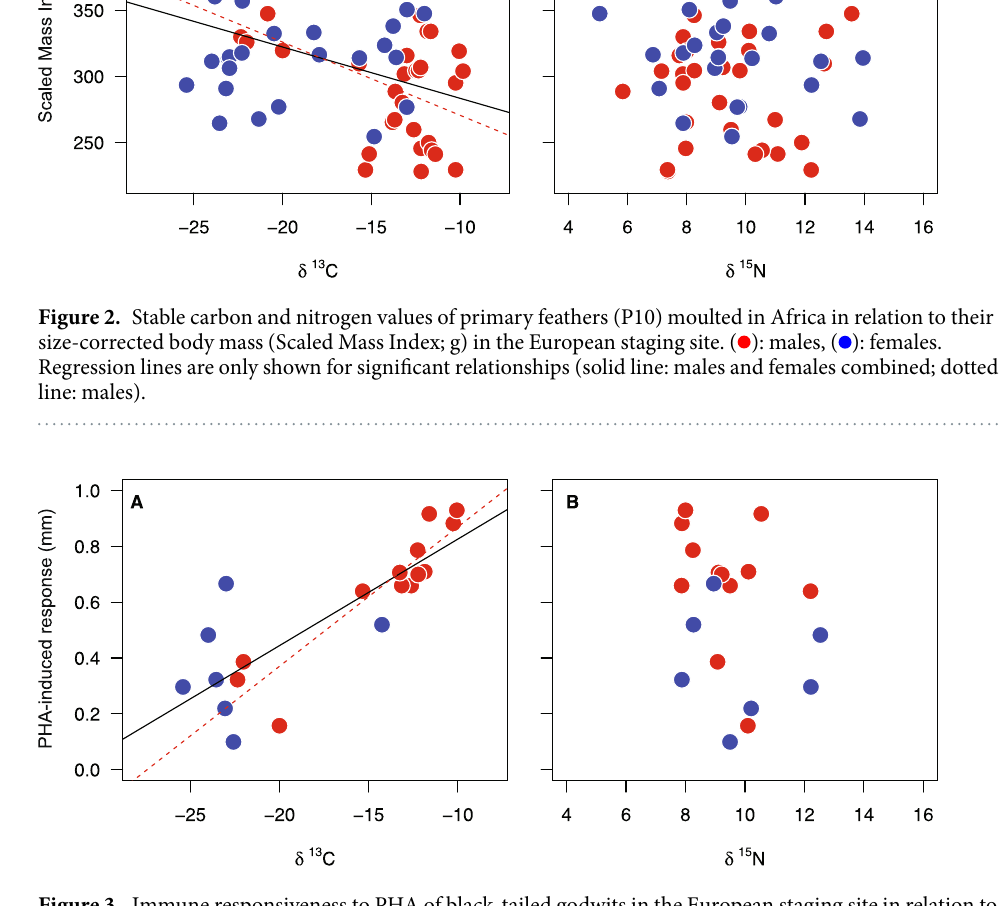
Figure 3. Immune responsiveness to PHA of black-tailed godwits in the European staging site in relation to stable carbon and nitrogen values of primary feathers moulted previously in Africa. ( ): males, ( ): females. Regression lines are only shown for significant relationships (solid line: males and females combined; dotted line: